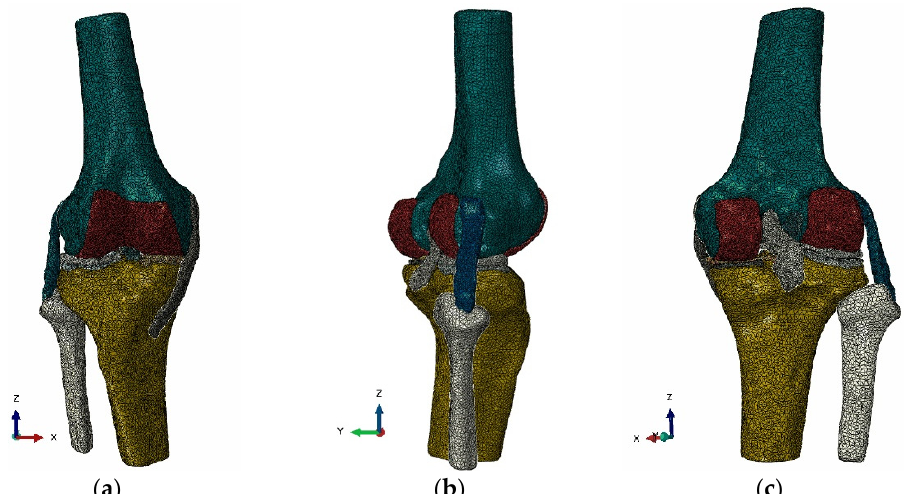
Figure 2. Finite element model of the right knee joint: ( a ) Front view; ( b ) Side view; ( c ) Rear view.